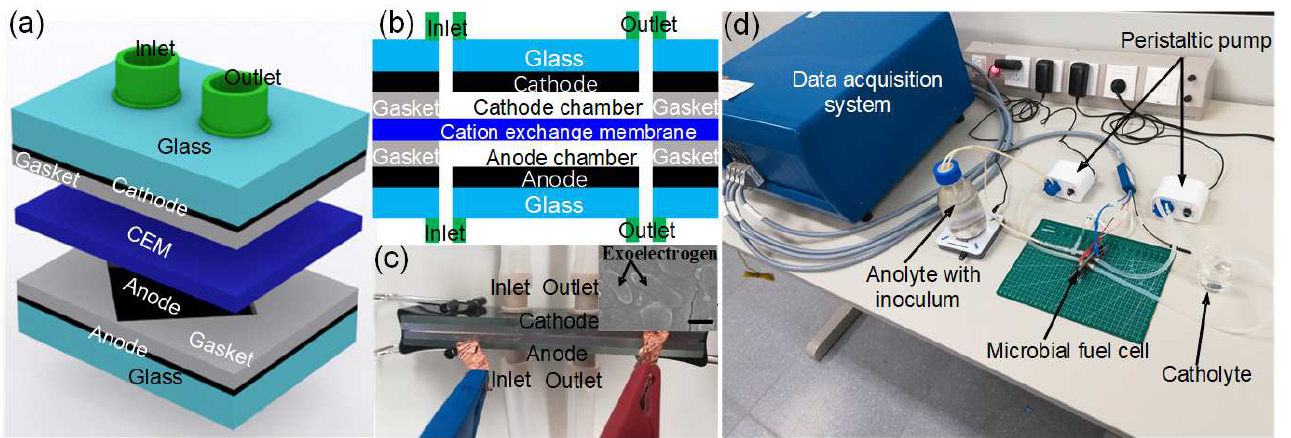
Figure 1. ( a ) Schematic of the lateral view of the microscale MFC biosensor; ( b ) Cross-sectional view of the microscale MFC biosensor; ( c ) Optical image of the microscale MFC biosensor; inset: SEM image of the exoelectrogen on the anode (scale bar: 500 nm); ( d ) Optical image of the microscale MFC biosensor